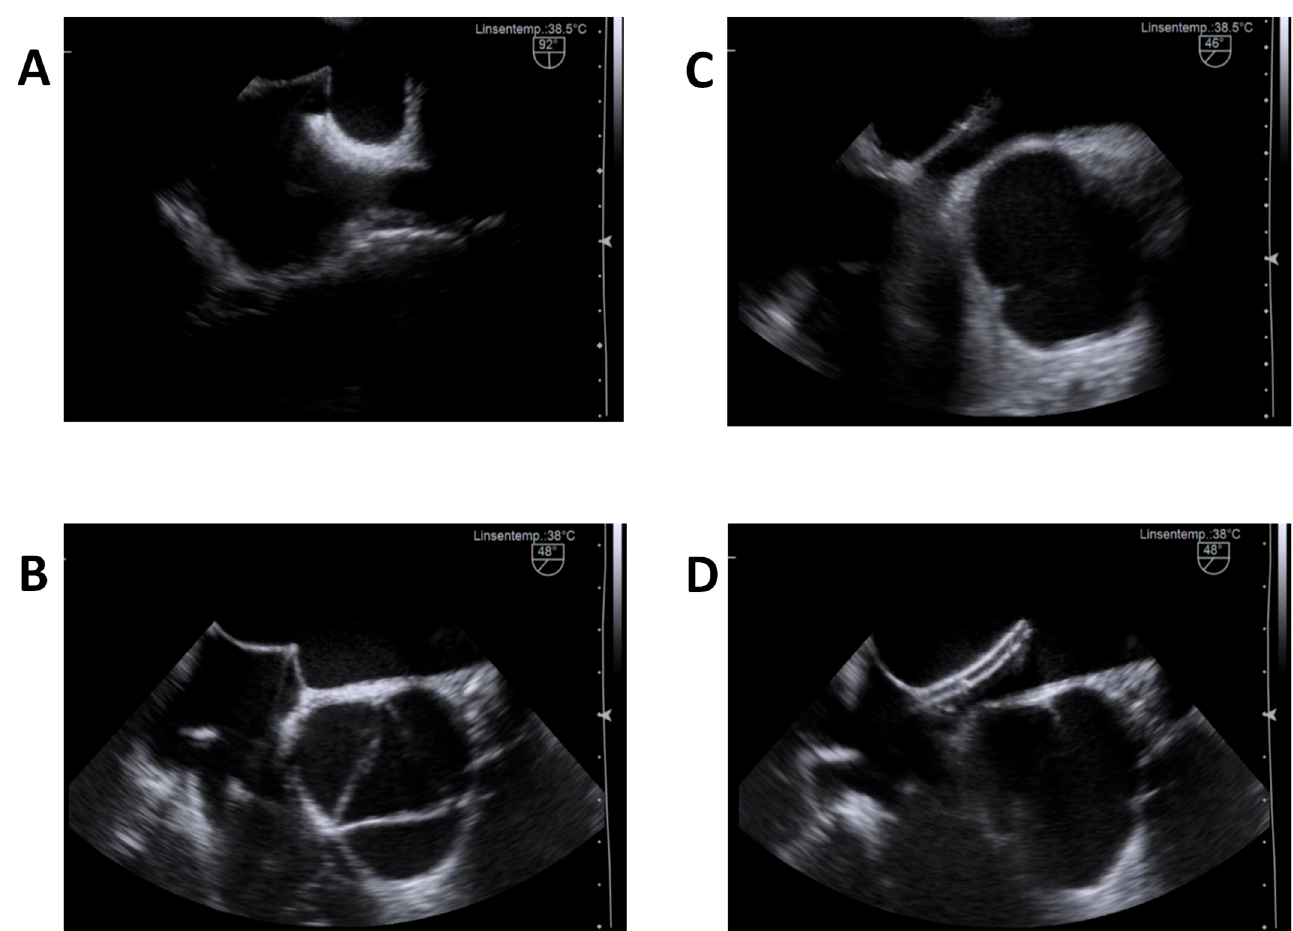
Figure 1. Illustrative TEE—views of the transseptal puncture procedure. ( A ) shows septal tenting immediately after retraction of the sheath in the bicaval view (90–110°, usually). ( B ) shows the advanced needle aligned in an optimal direction, away from the aortic root, as well as within acceptable distance to the posterior left atrial wall. ( C ) catches the instance of septum perforation in the same patient. ( D ) illustrates the advanced introducer sheath within the left atrium.